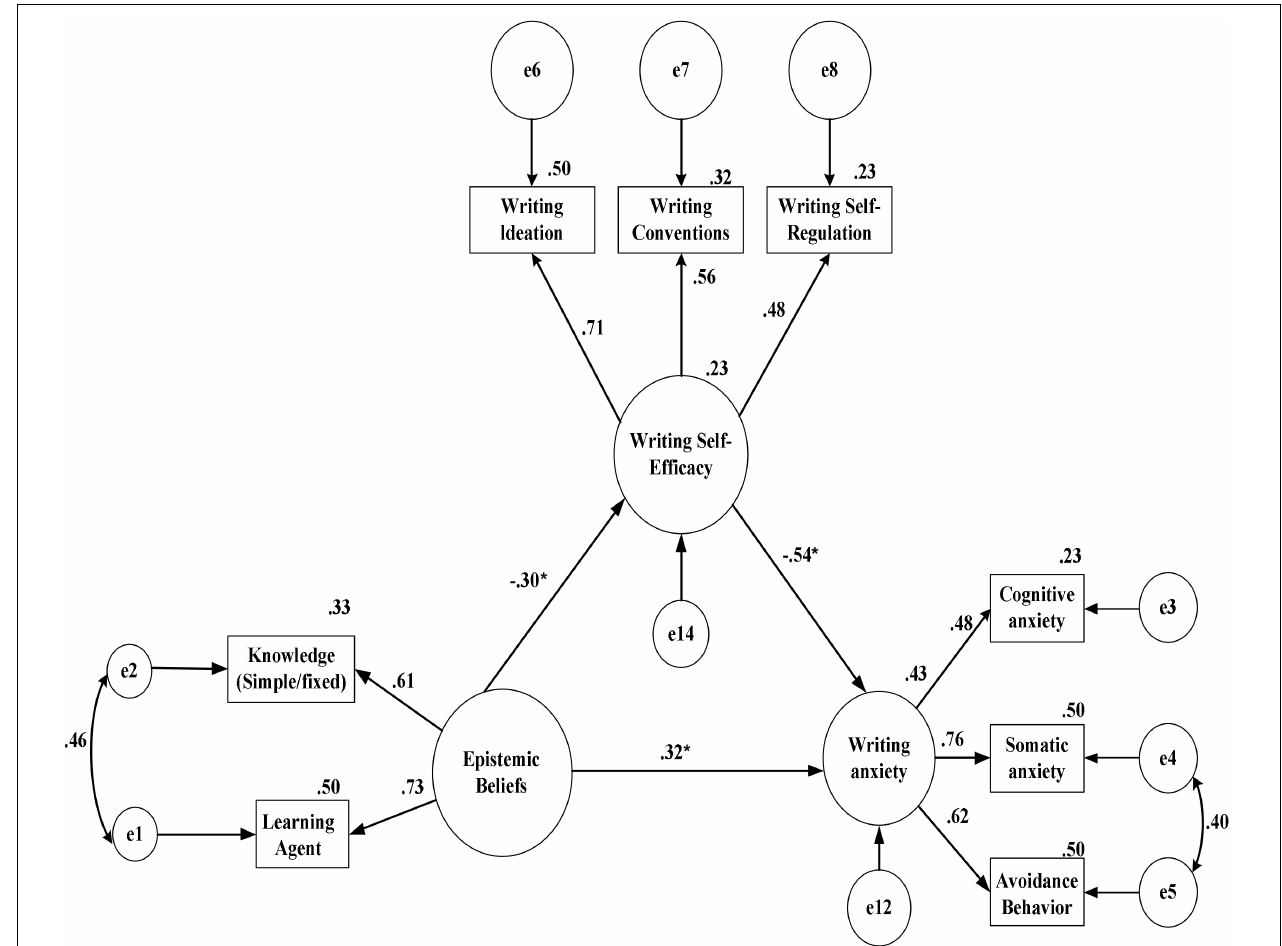
FIGURE 5 | Finalized unstandardized test for direct and indirect paths in predicting L2WA with respect to WSE and L2WA. * p < 0.05.